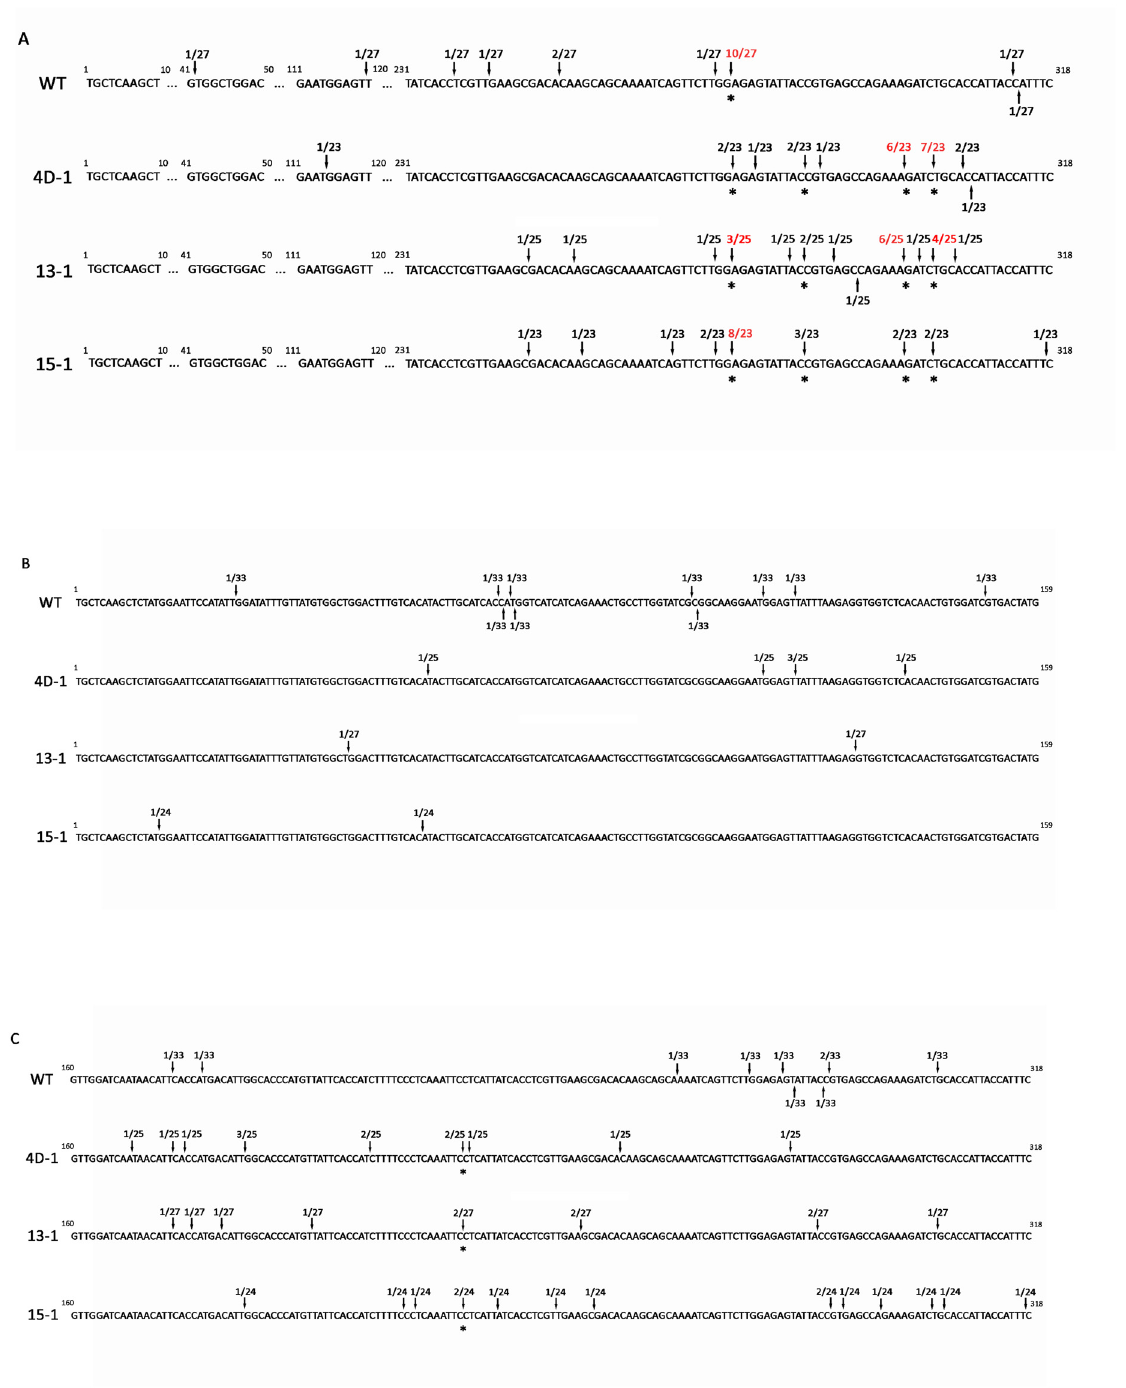
Fig 8. 5 ’ RACE on Gm FAD3A and Gm FAD3C mRNAs in T 5 RNAi lines. Arrows indicate the inferred cleavage sites and numbers above represent the fractions of cloned 5 ’ RACE PCR products terminating at this position. Degradation sites detected with high frequency are highlighted in red, and those present across the three RNAi lines are highlighted with asterisks. (A) Summary of the 5 ’ RACE analysis performed on the 318-bp region of Gm FAD3A mRNA. (B) and (C) Summary of the 5 ’ RACE analysis performed on the corresponding region of Gm FAD3C mRNA.